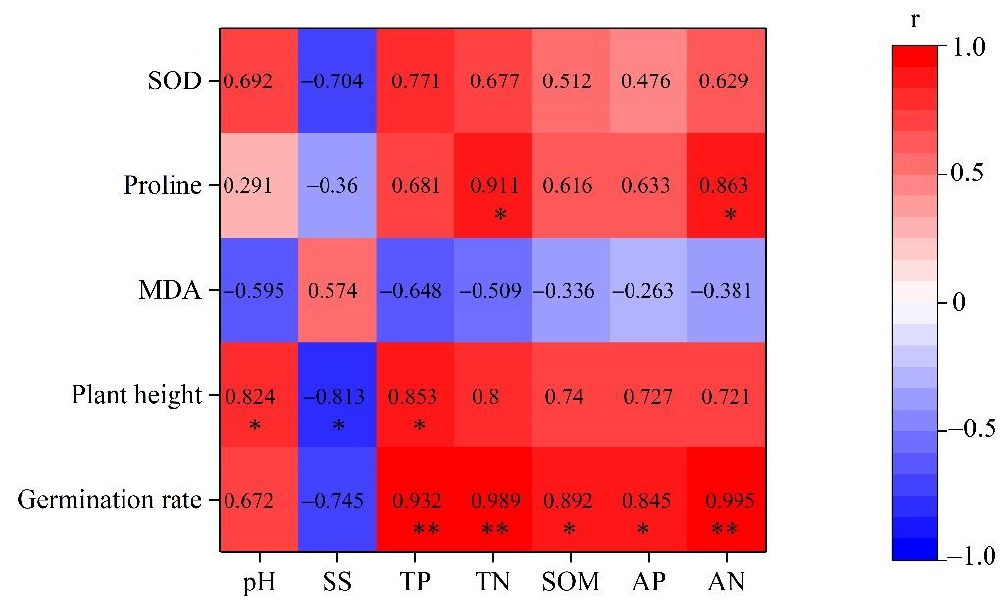
Figure 4. Heat map of the Pearson correlation analysis between maize physiological indices and soil physiochemical properties. *, p < 0.05, **, p < 0.01. SS means soluble salts.